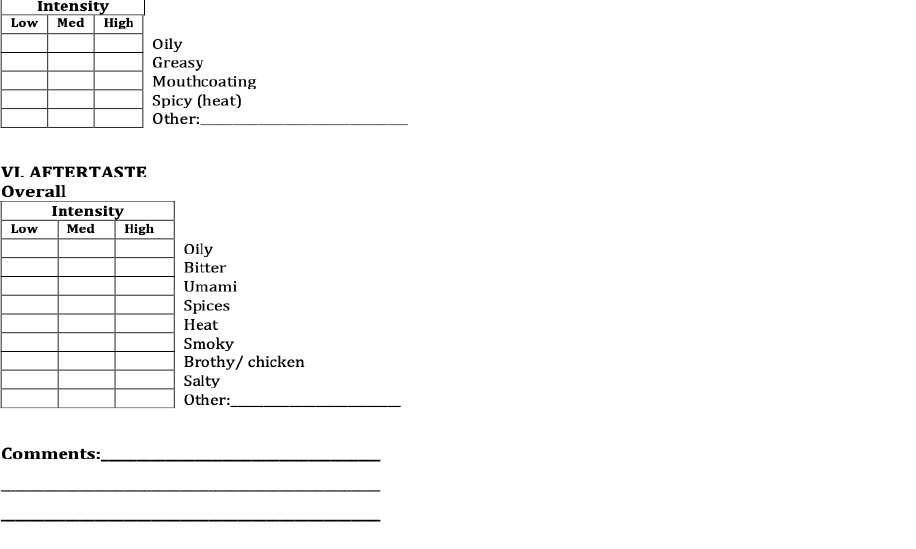
Figure 2. List of the sensory attributes tested for the MAPS-jambalaya and the control with RATA questions.